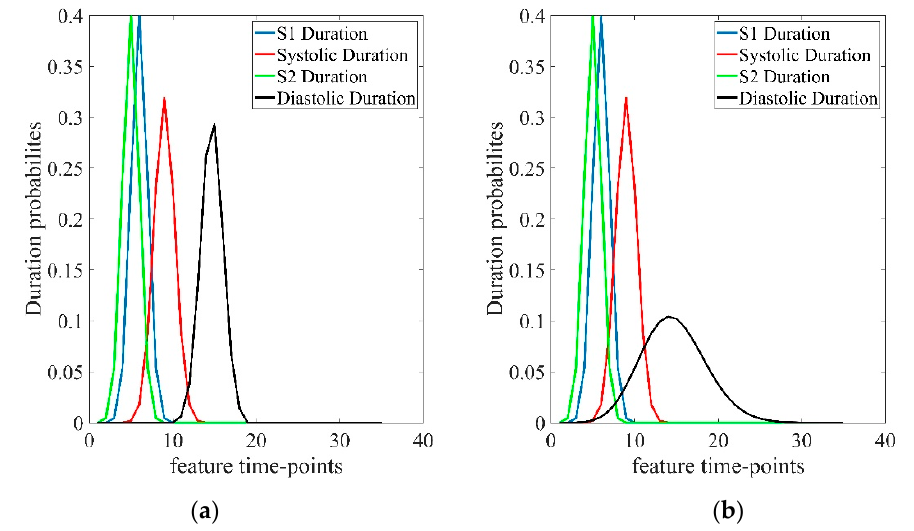
Figure 9. Duration probabilities for four states. The S1, systole, and S2 duration probabilities follow the Gaussian distribution. ( a ) Gaussian distribution for diastolic duration. ( b ) Poisson distribution for diastolic duration.